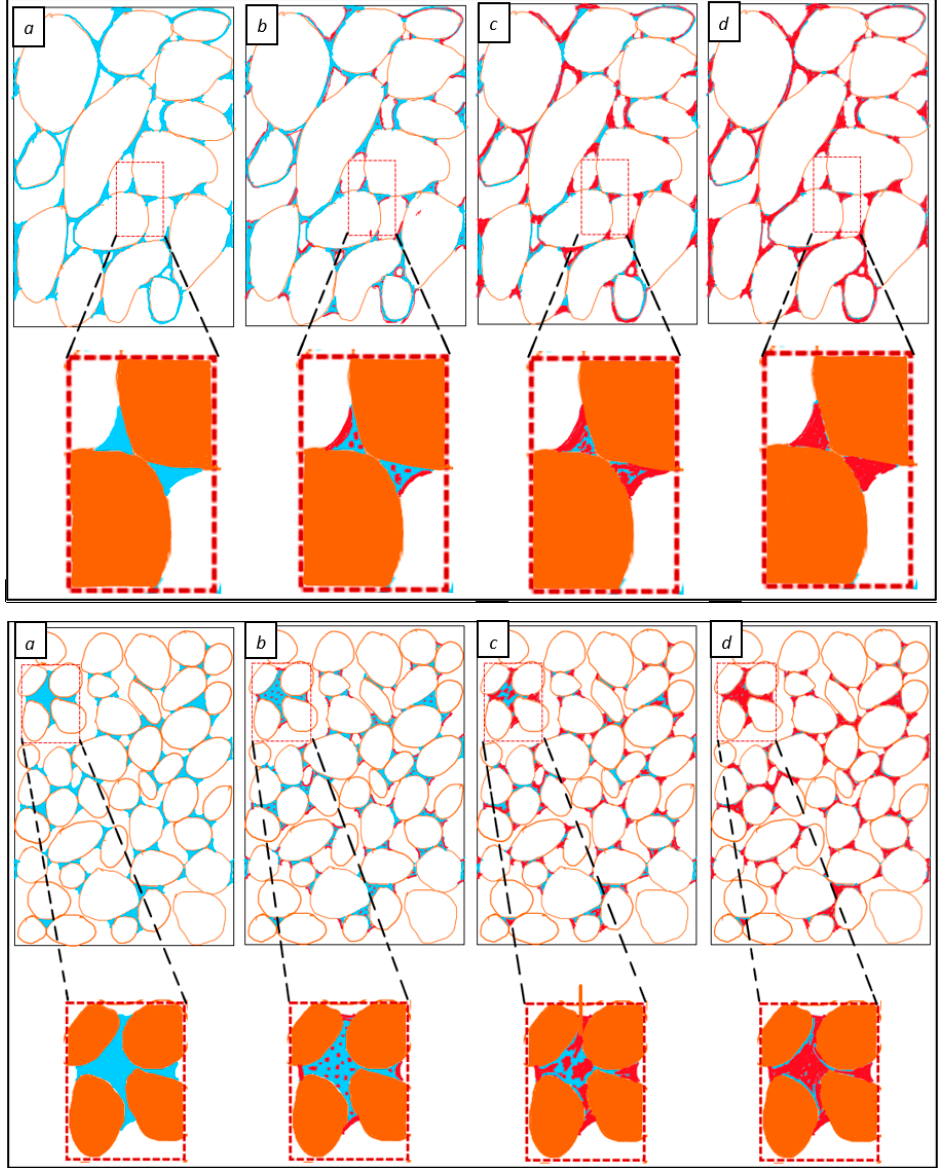
Figure 14. Schematic of the conceptual model for water distribution and hydrate formation in coarse (Top set) and fine sand (Bottom set): ( a ) at the start of test and before hydrate formation where water (blue) distribution is more at the contacts for coarse sand (brown) versus around the grains and in smaller pores due to suction for fine sand, ( b ) just as the hydrate formation initiates, the more nucleation points (red) for fine sand lead to faster methane consumption initially, ( c ) thickening of hydrate rind and coarsening of hydrate, and ( d ) conceptual model for the hydrate distribution at the end of hydrate formation where there could still be bound water around the grains in fine sand, thus the lower value of stiffness and higher value of damping (see Figure 15 for stiffness evolutions and damping behavior) for hydrate-bearing finer sands compared to hydrate-bearing coarser sands (see Figure 16).